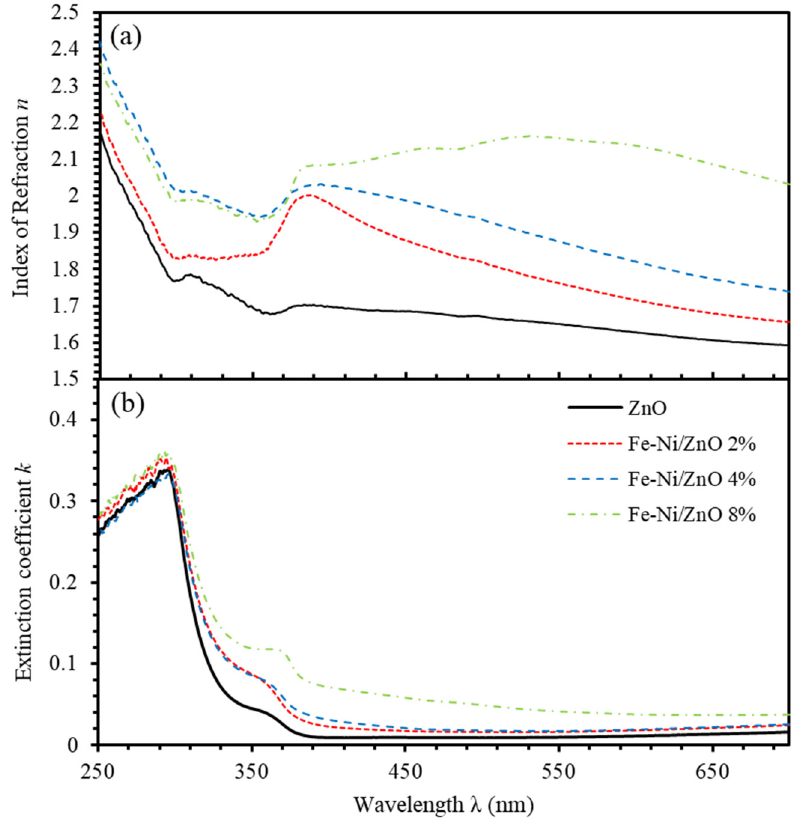
Figure 7. ( a , b ) The index of refraction ( n ) and extinction coe ffi cient ( k ) of undoped ZnO and (Fe-Ni) Figure 7. ( a,b ) The index of refraction ( 𝑛 ) and extinction coefficient ( 𝑘 ) of undoped ZnO and (Fe-Ni) co-doped ZnO thin films for di ff erent Fe-Ni co-doping co-doped ZnO thin films for different Fe-Ni co-doping levels.